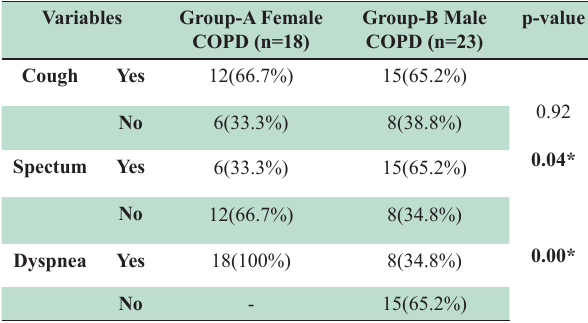
Table-II: Association of gender with presenting complain of smokers having COPD. Values are given in frequencies and percentages.